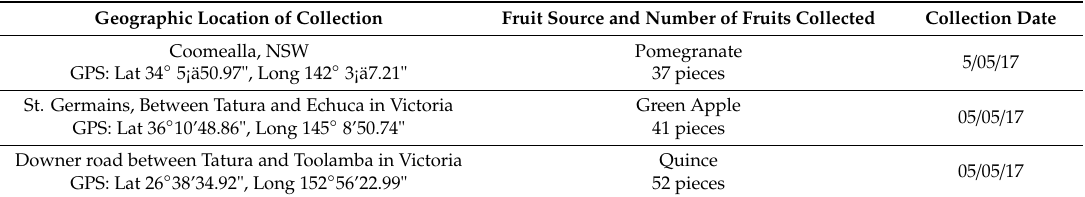
Table 3. Fruit types and origin used for the wild-type Bactrocera tryoni colony (G0). Geographic Location of Collection Fruit Source and Number of Fruits